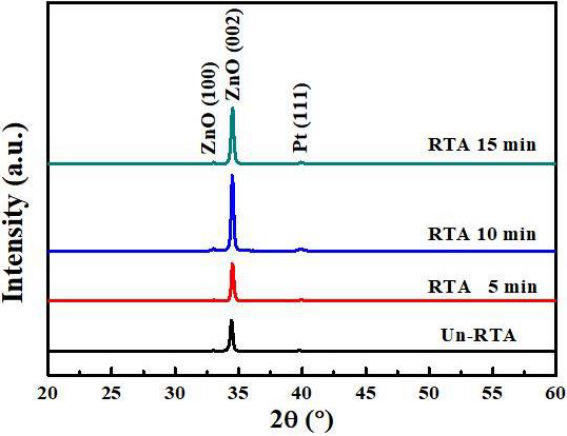
Figure 3. XRD patterns of the ZnO thin films annealed at 400 °C with various times.